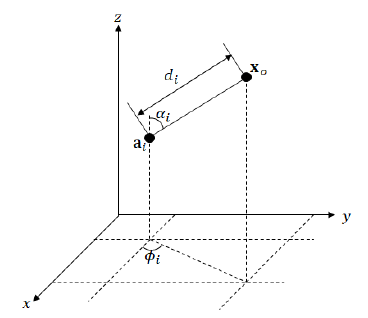
Figure 1. Anchor node and target location in a 3-D